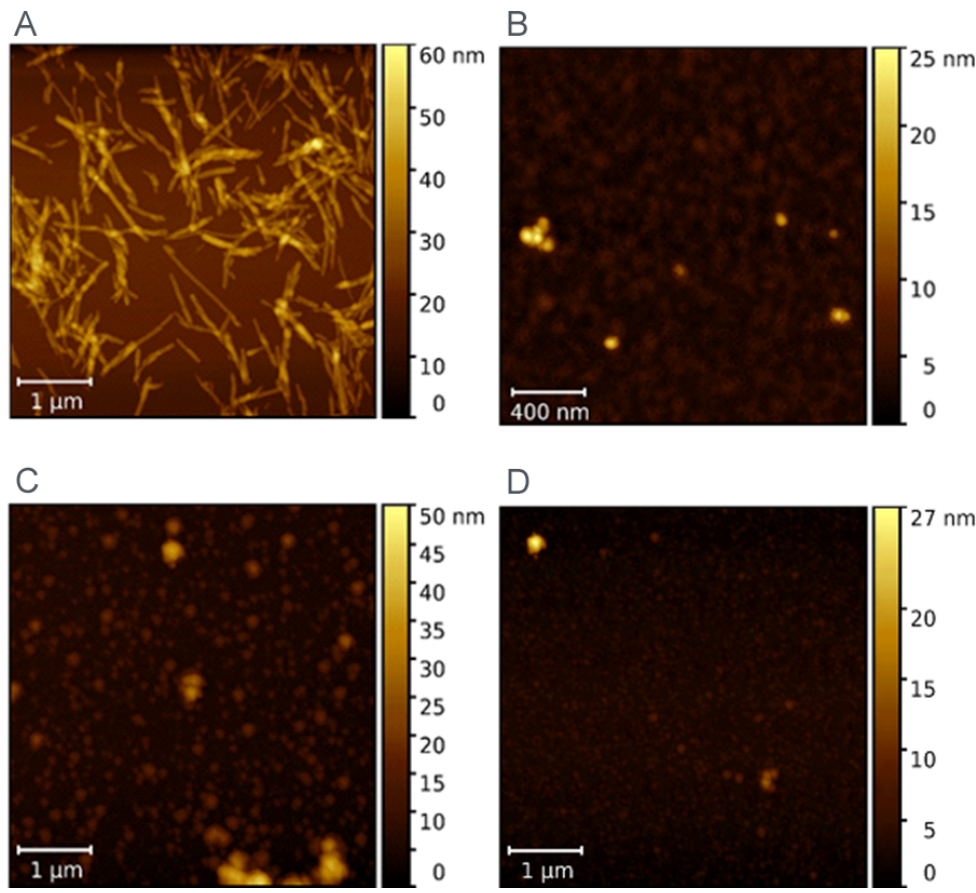
Figure 3. AFM image of the pure LAF ( A ) and pure MF ( B ), and visualization of the LAF after incubation with RF ( C ) and MF ( D ).